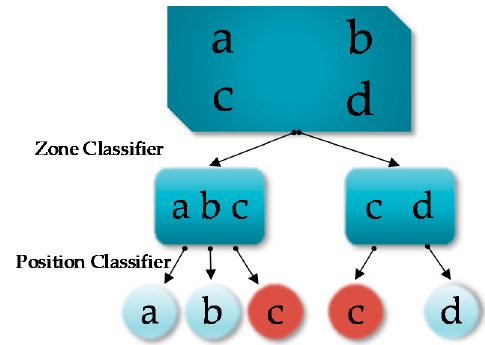
Figure 3. Proposed hierarchical indoor localization system. Figure 4. Hierarchical classification-based indoor positioning with zone overlap.